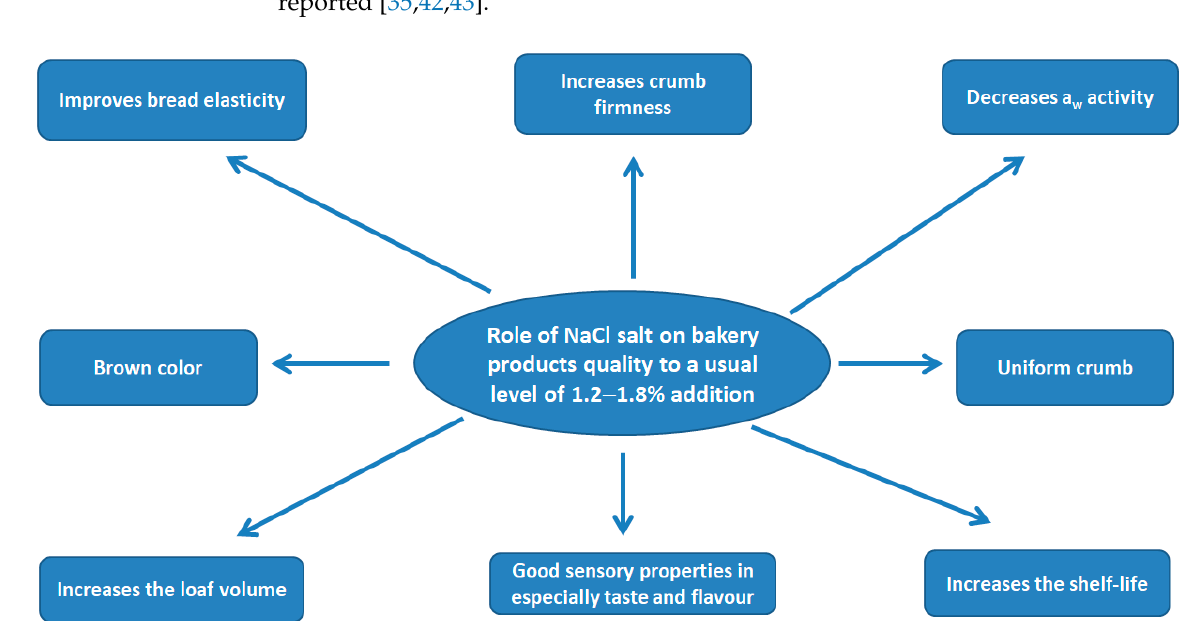
Figure 3. The role of sodium chloride on bakery products quality .